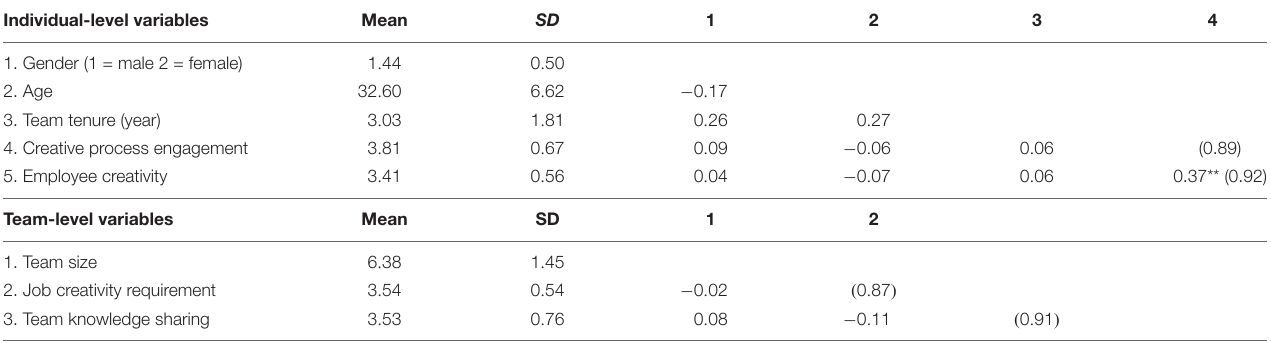
TABLE 1 | Descriptive statistics, correlations, and reliabilities.